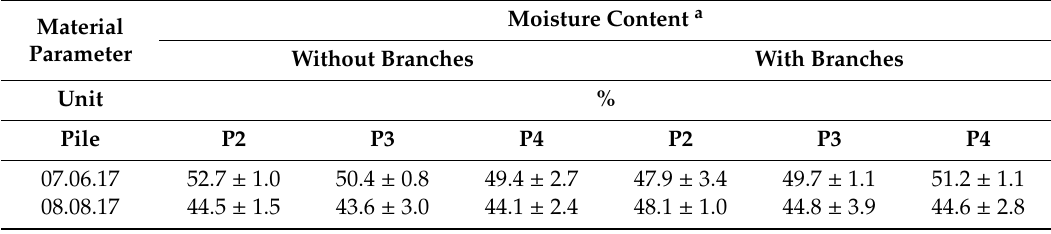
Table 5. Drying of trees with and without branches in Schwarzbach ( ± standard